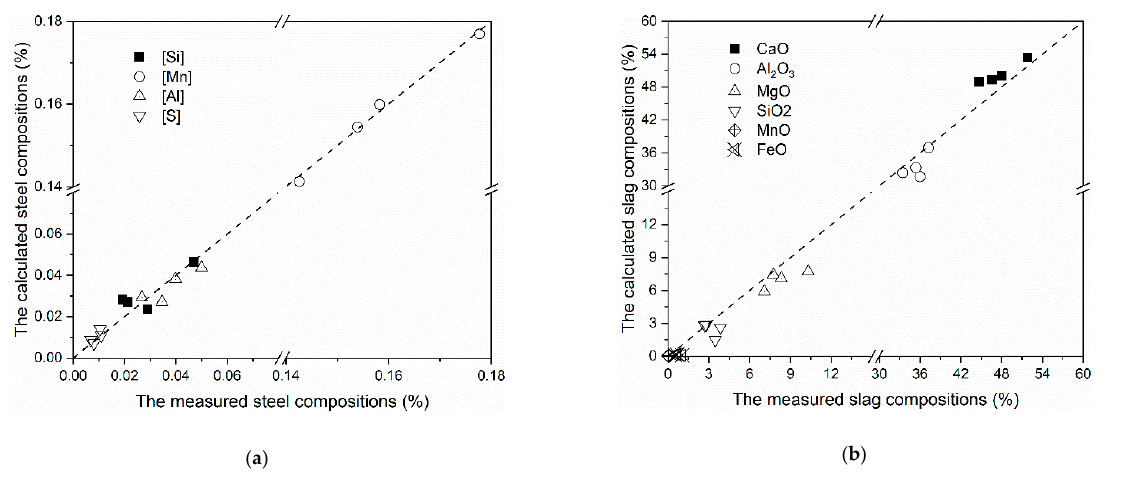
Figure 2. The comparison of the calculated and measured final compositions in ( a ) steel ( b ) slag after LF refining (“[]” indicates dissolved value) [15,16].